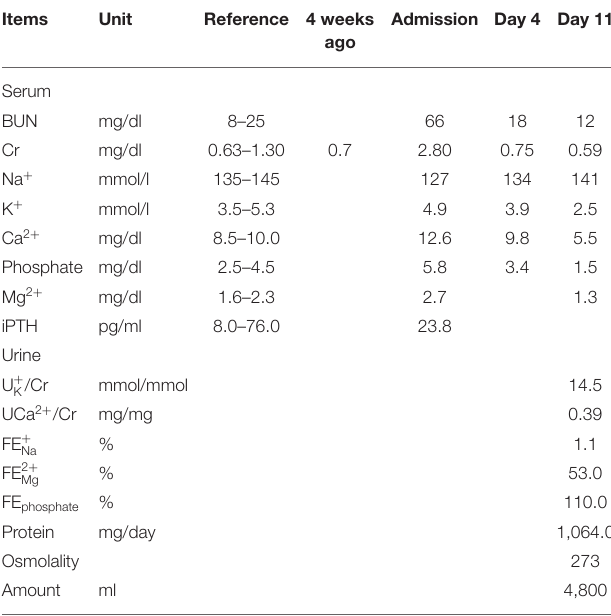
TABLE 1 | Changes of laboratory values.